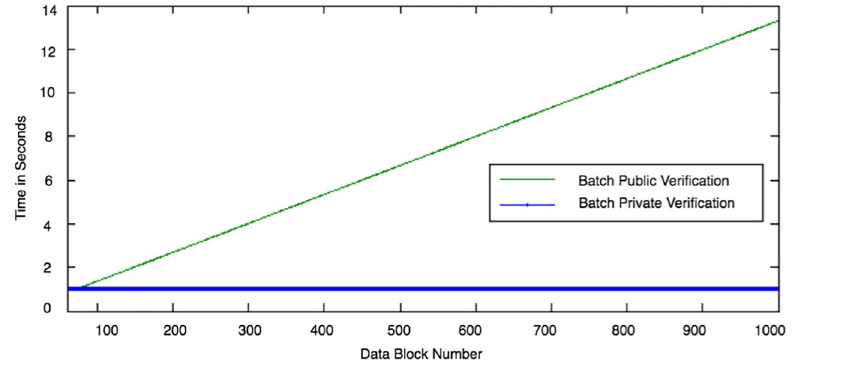
Fig 16. Batch verification cost: Private vs